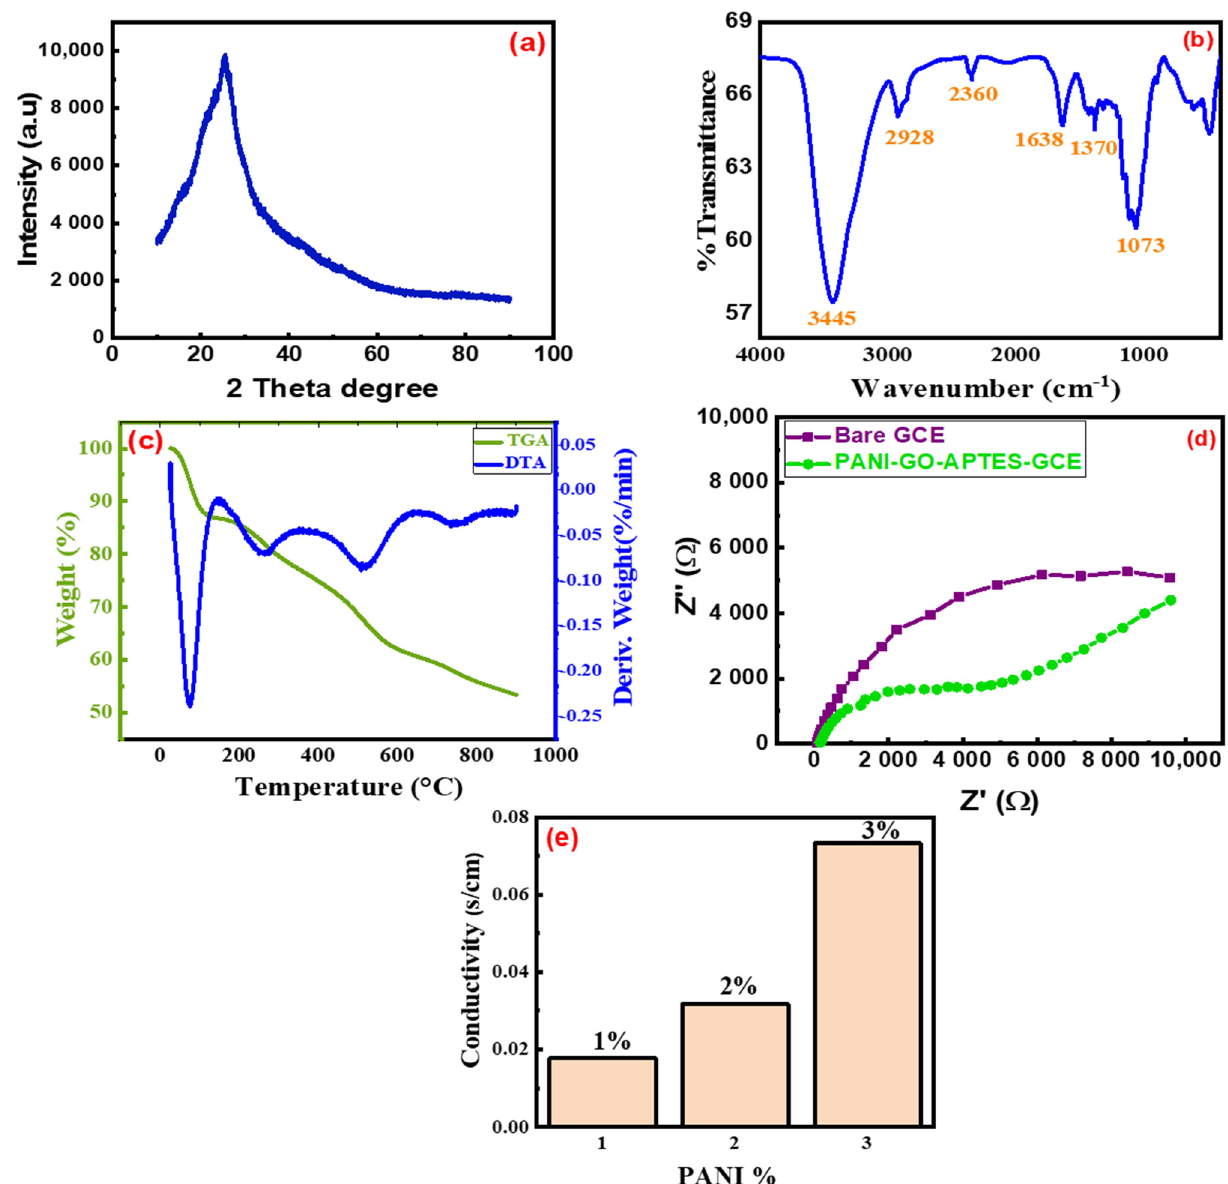
Figure 3. ( a ). XRD spectrum recorded for PANI-GO-APTES. ( b ) FTIR spectrum recorded for PANI-GO-APTES. ( c ). Rec- orded TGA and DTA spectra. ( d ) Recorded EIS spectrum in potassium ferricyanide. ( e ) Recorded electrical conductivity values for GO/APTES nanocomposite with PANI loading of 1%, 2% and 3% at room temperature .